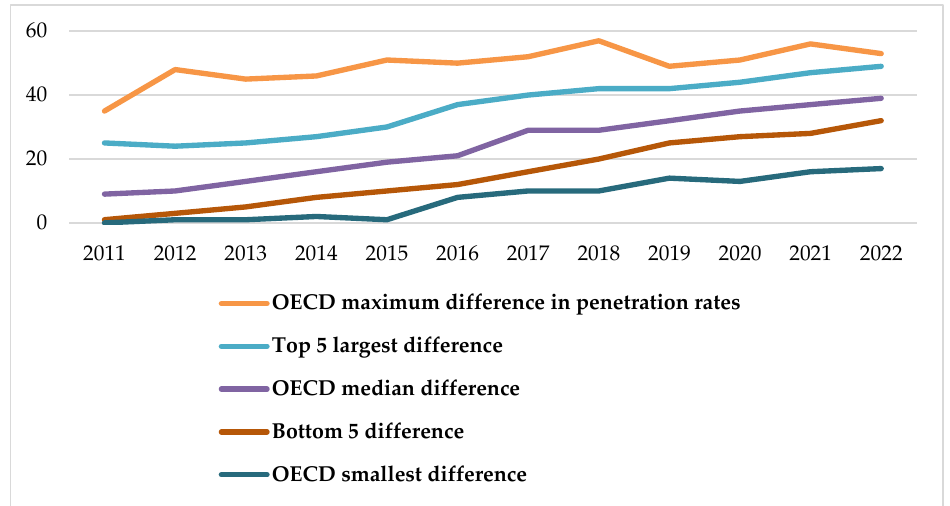
Figure 10. Differences in penetration rates across small and large firms, 2011 to 2022. Source: Adapted from Ref. [77].